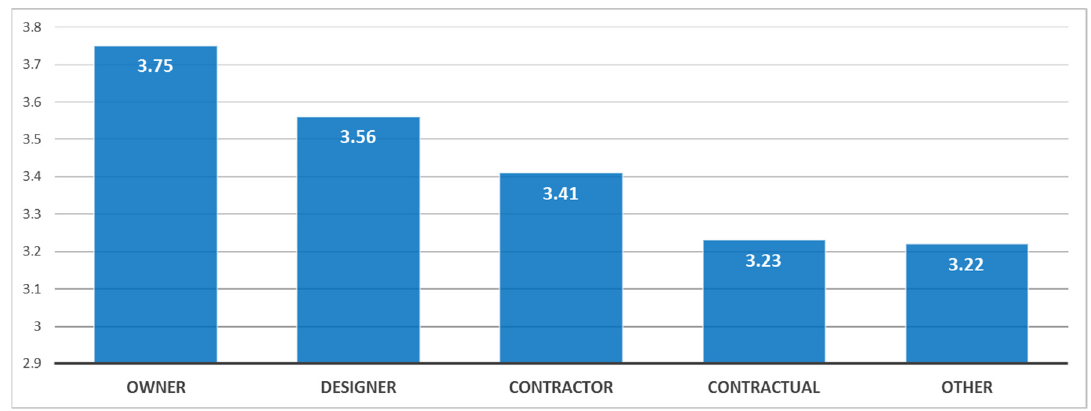
Figure 1. Weighted Average of Dispute Categories in the UAE Construction Industry. Figure 1. Weighted average of dispute categories in the UAE construction